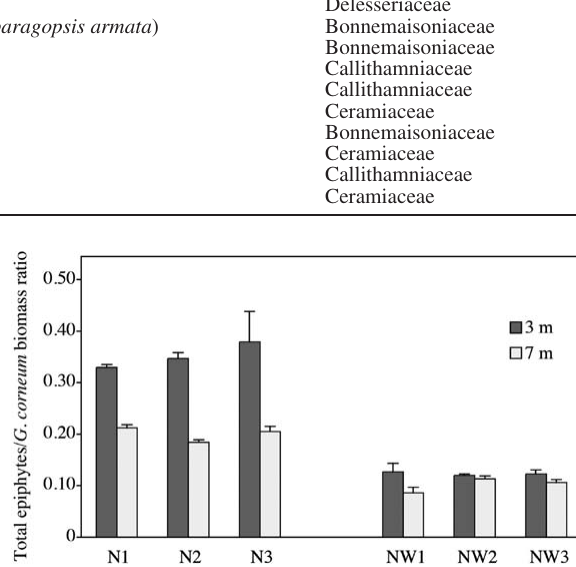
Fig. 2. – Plot showing the interactive effect of coastal orientation (North: N1, N2, N3; Northwest: NW1, NW2, NW3) and depth (3